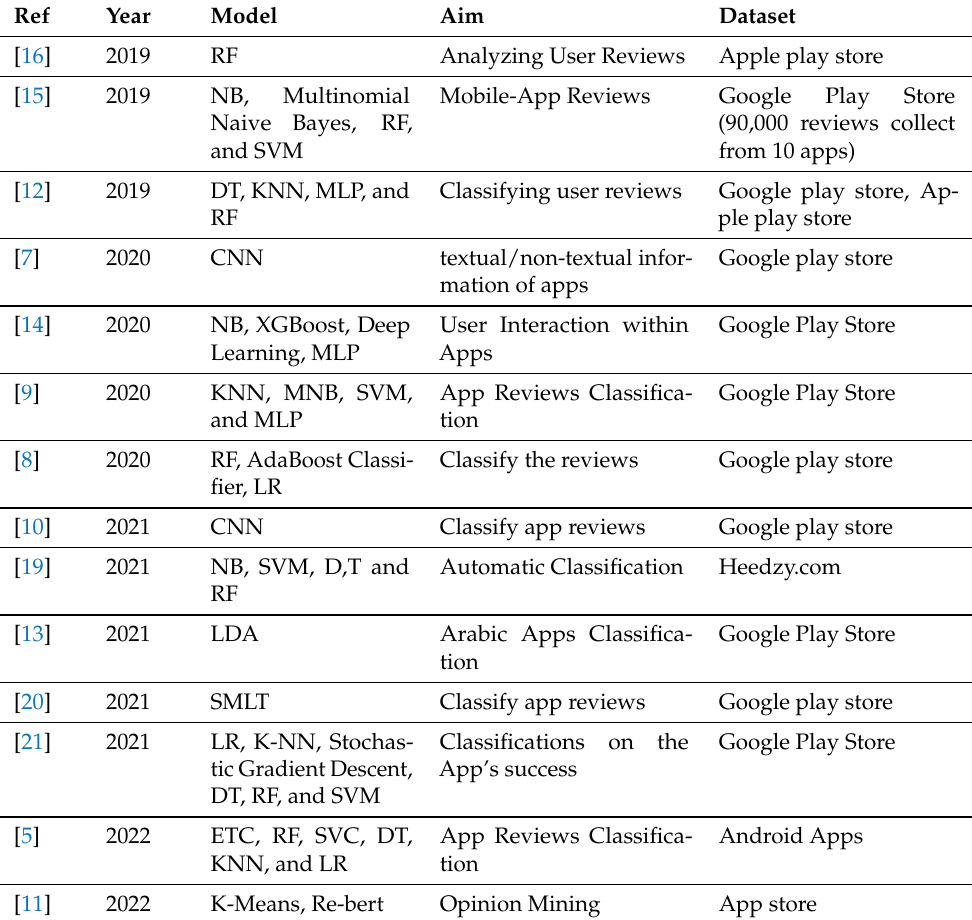
Table 2. A summary of the related